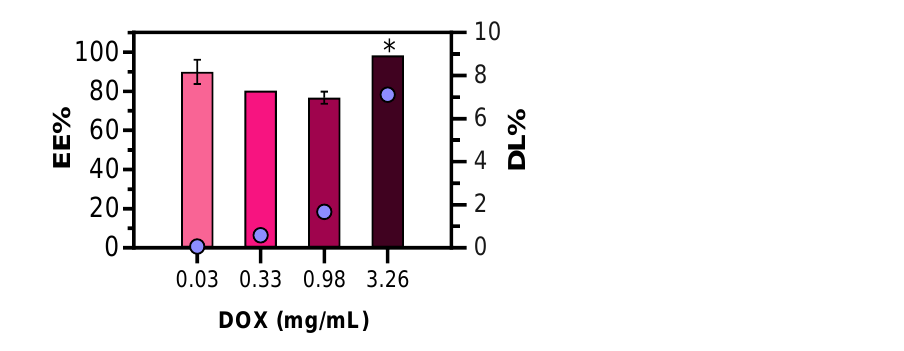
Figure 7. EE and DL of DOX-M3 at different DOX concentrations (0.03–3.26 mg/mL). The data are expressed as mean ± standard deviation of three independent measurements. * p value < 0.05. One- way ANOVA followed by the Bonferroni post hoc comparative test were performed.